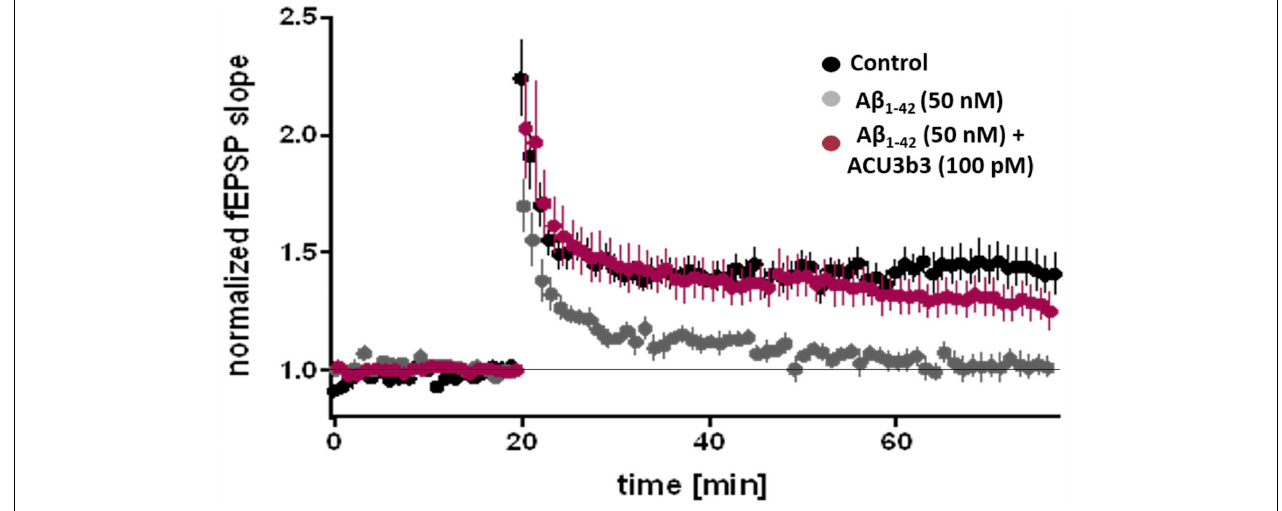
FIGURE 7 | Effects of ACU3B3 and ACU193 on A β O-induced change in LTP (Cline et al., 2019). Addition of 50 nM A β 42 to brain slice media forms A β Os that block normal LTP, however, pre-incubation with 100 pM ACU3B3 prevents LTP disruption. (see Rammes et al., 2011 for methods).